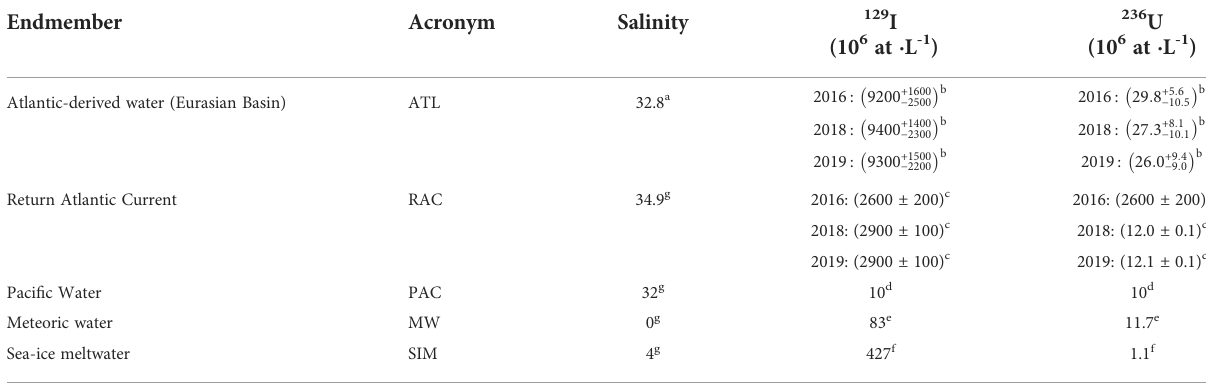
TABLE 1 Endmembers and corresponding salinity, 129 I, and 236 U concentration used in steady-state mixing models for PSW